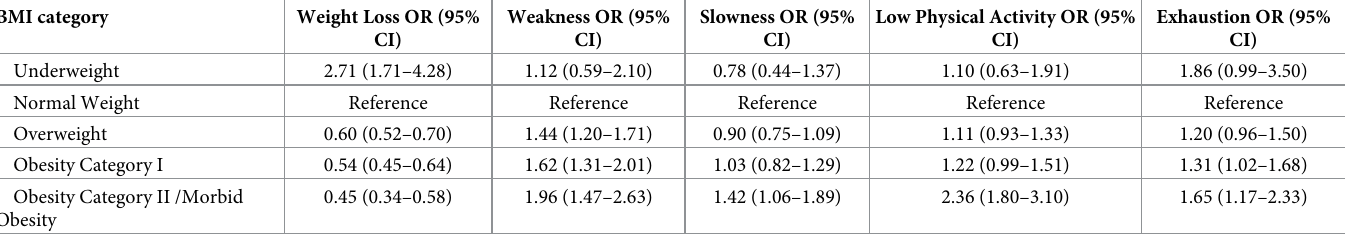
Table 3. Generalized estimating equation models for each frailty criterion as a function of BMI categories over 18-years of follow up among non-frail older Mexican Americans at baseline (N = 1,648).